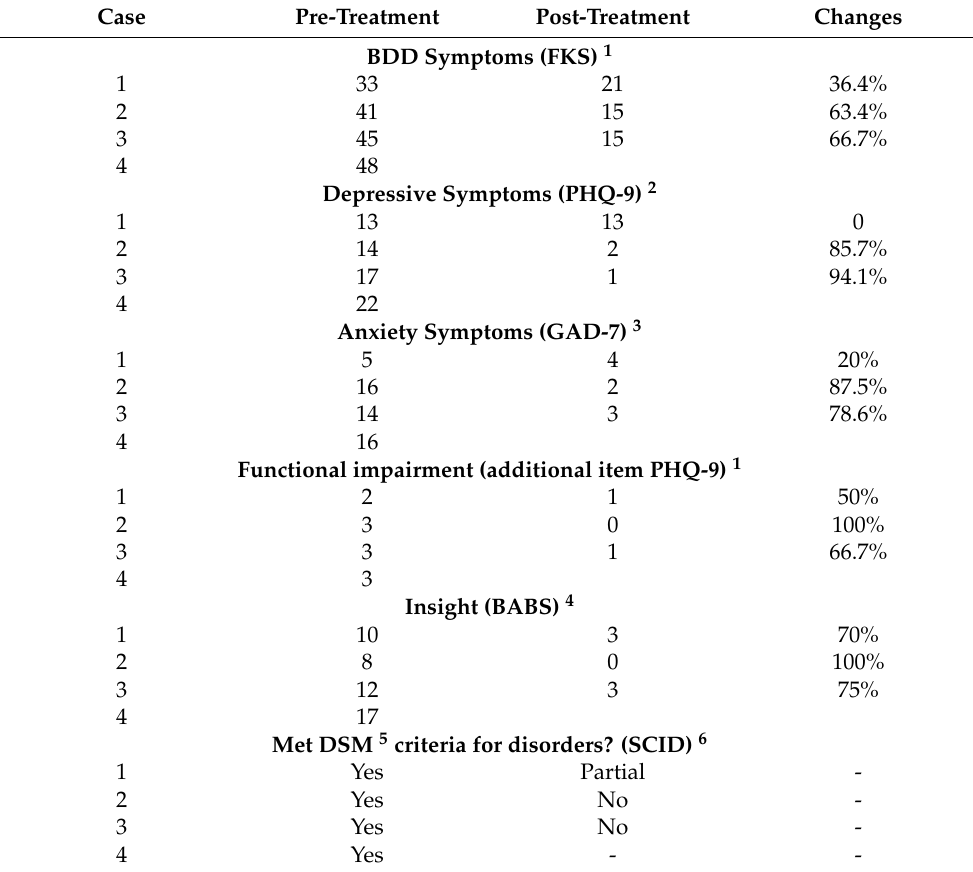
Table 2. Reported symptoms and treatment